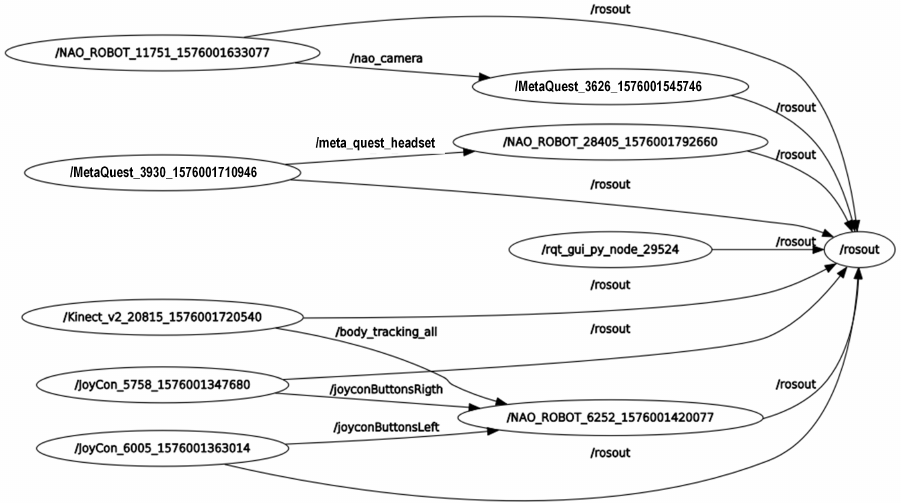
Figure 11. ROS rqt_graph, including the nodes and topics.